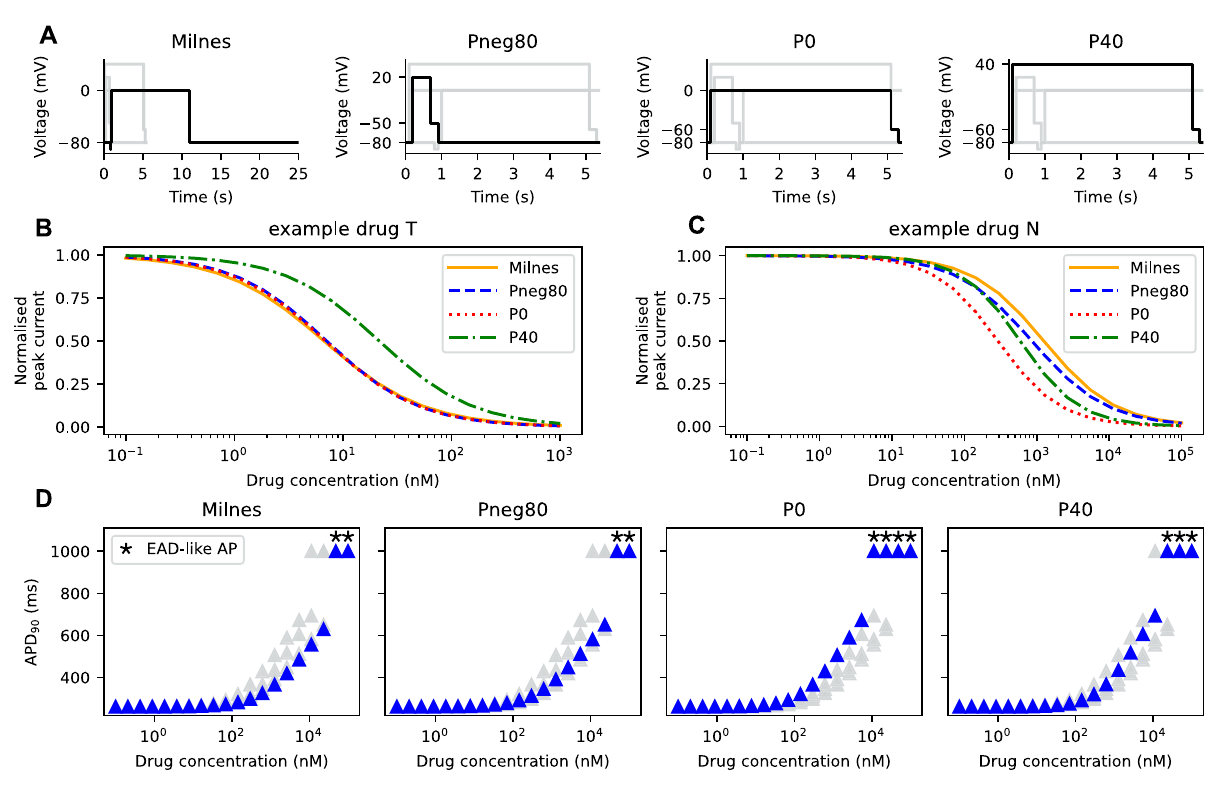
FIGURE 6 The Hill curves for an example drug T and an example drug N are protocol dependent, thus affecting the resultant APD prolongation. (A) The four protocols used to calibrate the hERG ionic conductance from the SD model. Note the differences in the time axes for visualisation purposes. The Hill curves of the peak I Kr simulated from the SD model under the protocols given in panel A for (B) an example drug T and (C) an example drug N. (D) The APD